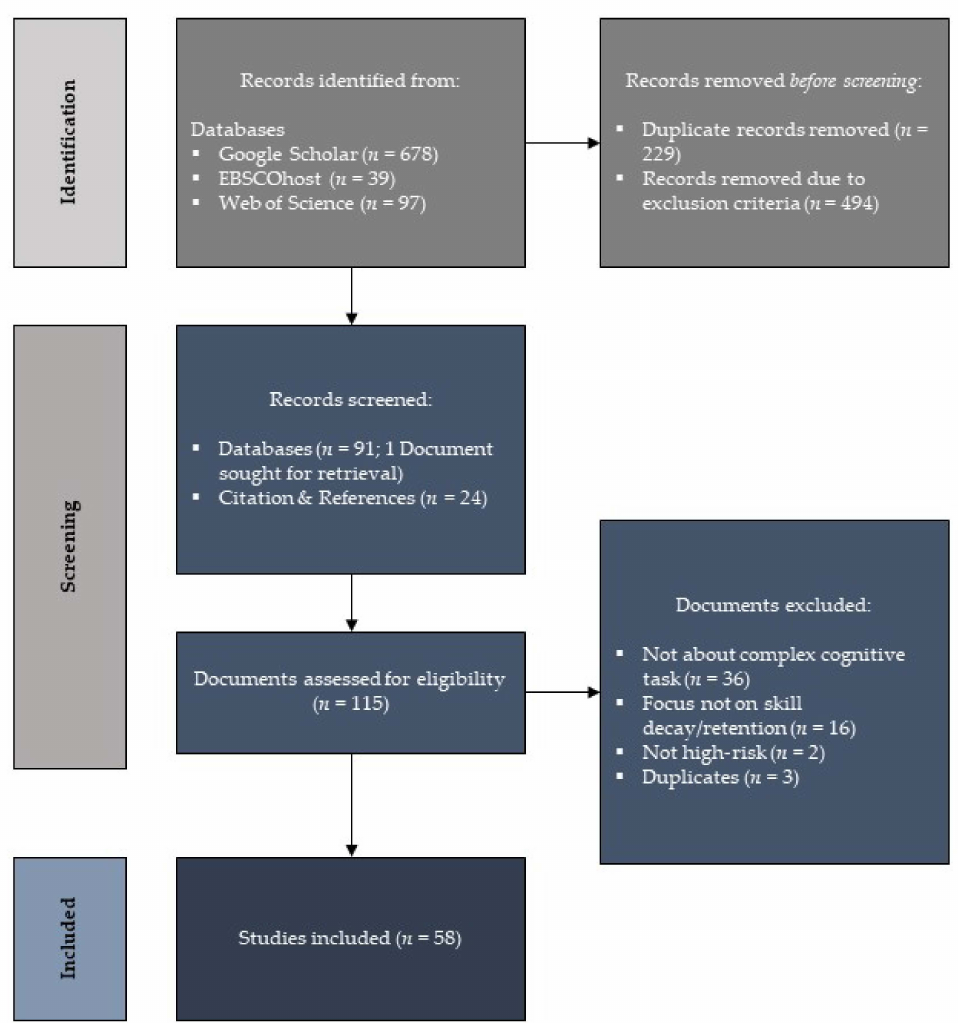
Figure 2. PRISMA flow diagram for systematic